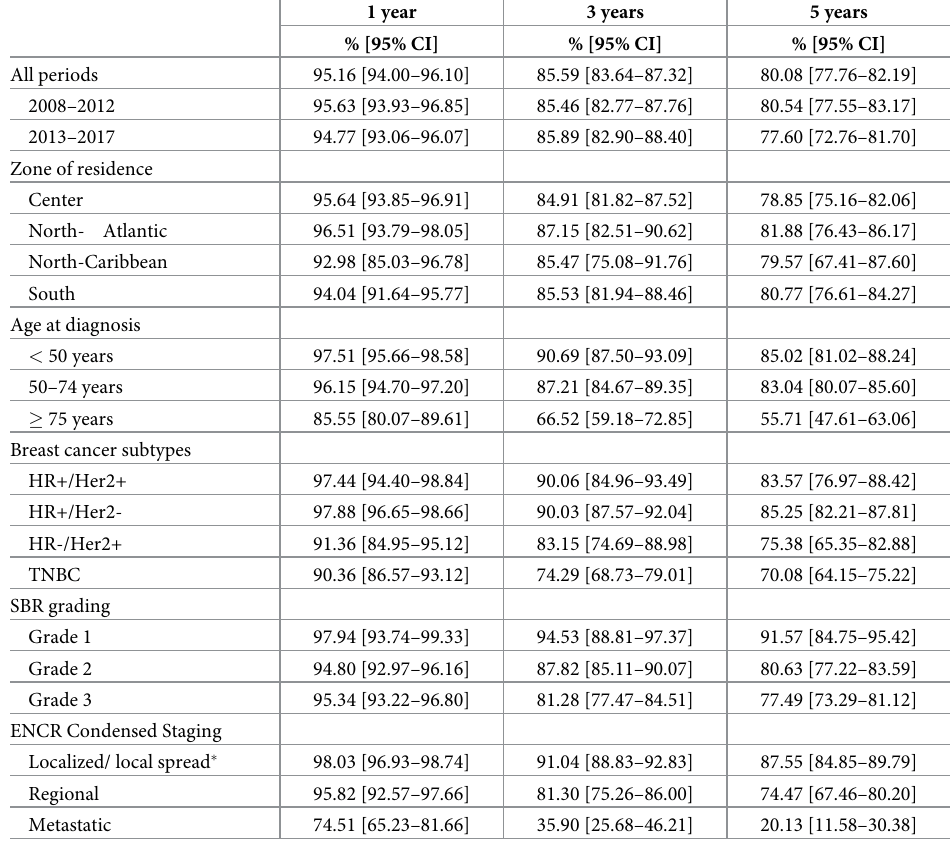
Table 2. Overall survival in patients with breast cancer in Martinique,